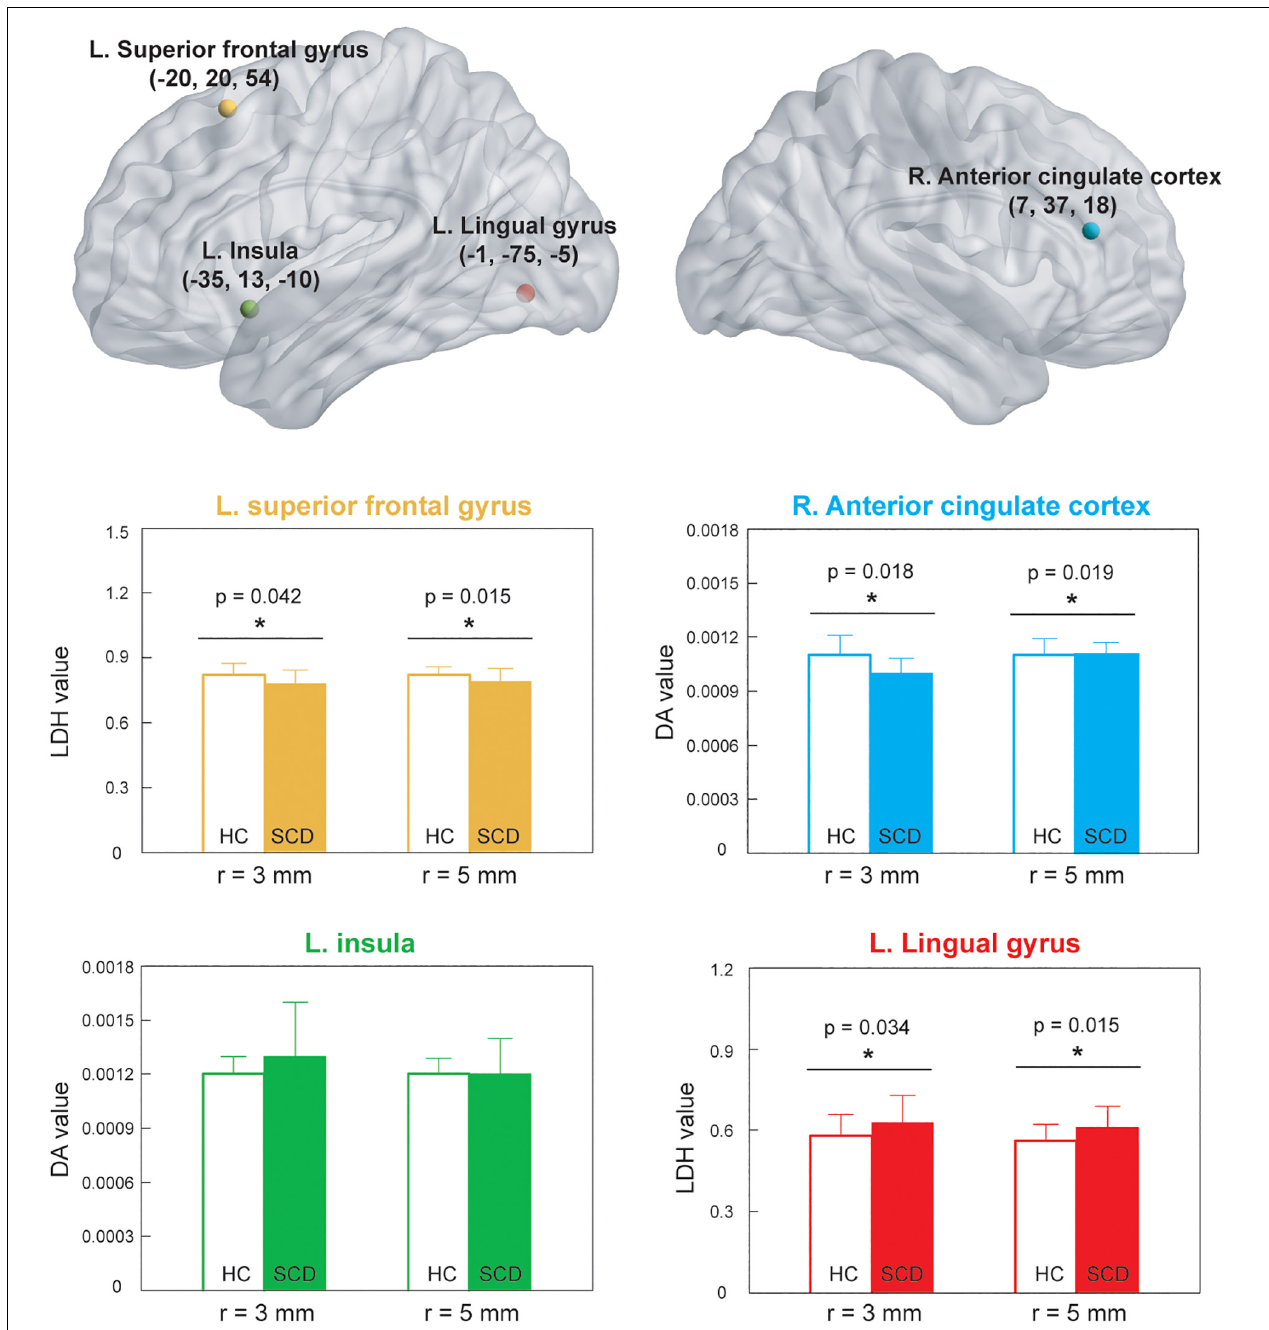
FIGURE 3 | ROI-based analysis was based on the significant locations shown in Figure 2 . * p < 0.05. HC, healthy control; SCD, subjective cognitive decline; ROI, region of interest; LDH, local diffusion homogeneity; DA, axial diffusivity; L, left; R,